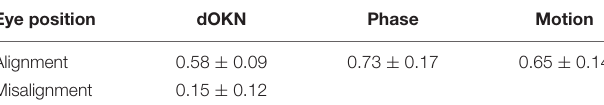
TABLE 3 | The ECR of